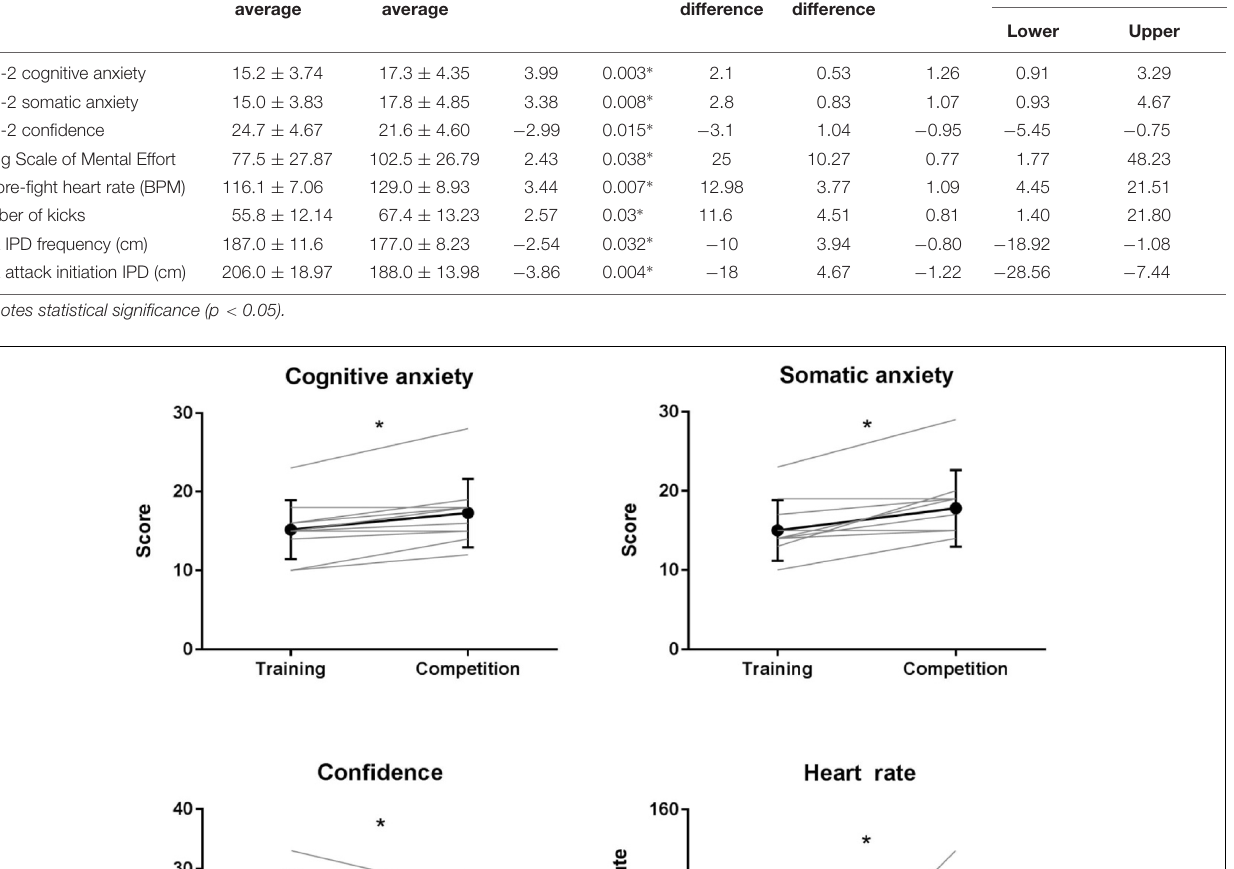
affective and cognitive demands of competition and